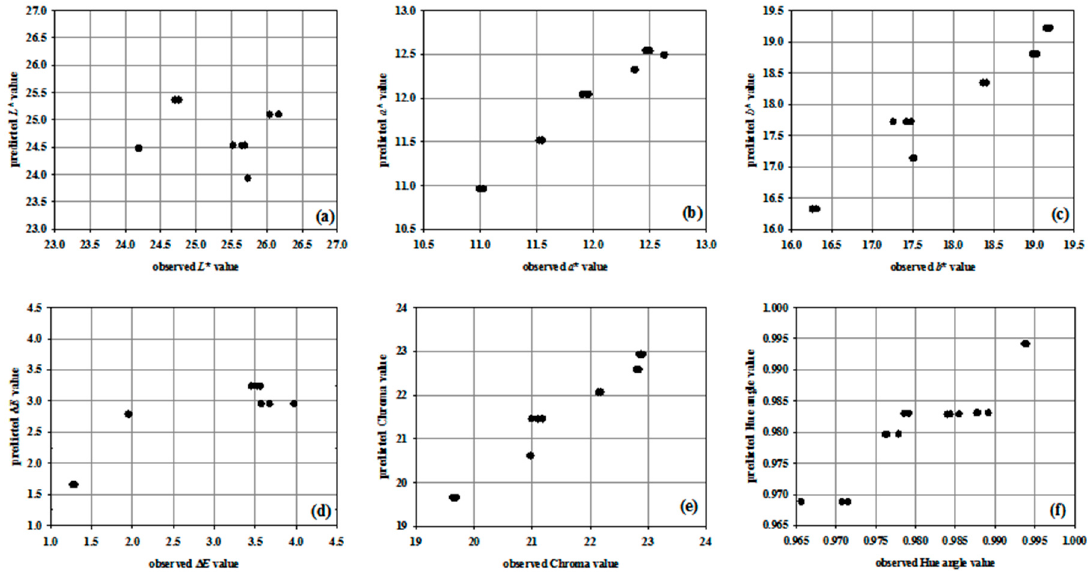
Figure 4. Non-linear regression models for description of colour component change during storage of V1KMK estimated using Statistica 10.0.: ( a ) L *, ( b ) a *, ( c ) b *, ( d ) Δ E , ( e ) Chroma, ( f ) Hue angle ( R 2 = 0.471, 0.990, 0.974, 0.918, 0.978, 0.918).